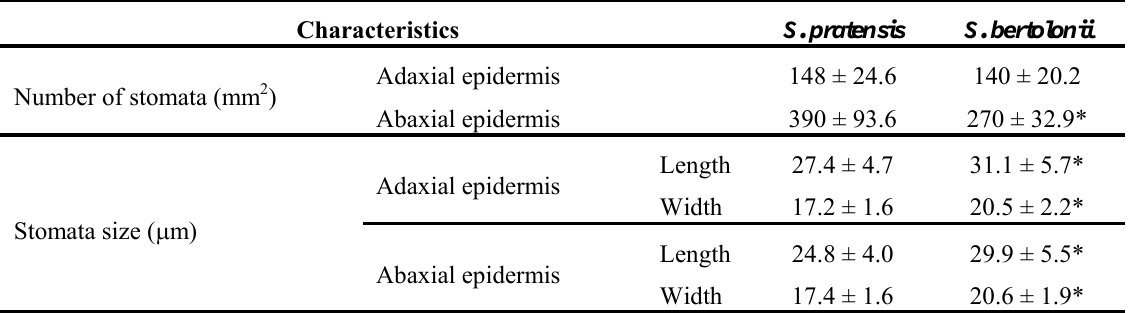
Table 2b. Number and size of leaf stomata in S. pratensis and S. bertolonii.